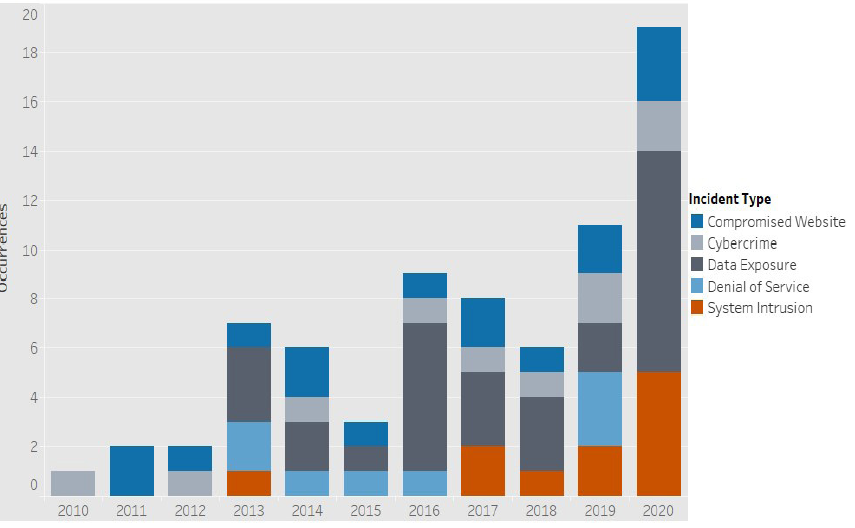
Figure 6: Yearly trends in incident types,